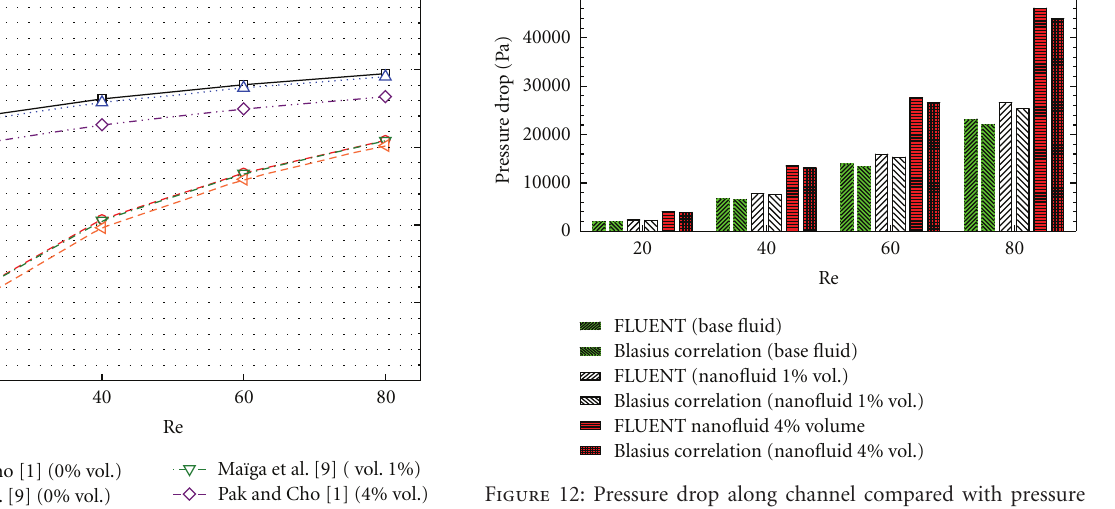
Figure 12: Pressure drop along channel compared with pressure drop estimated by Blasius formula.